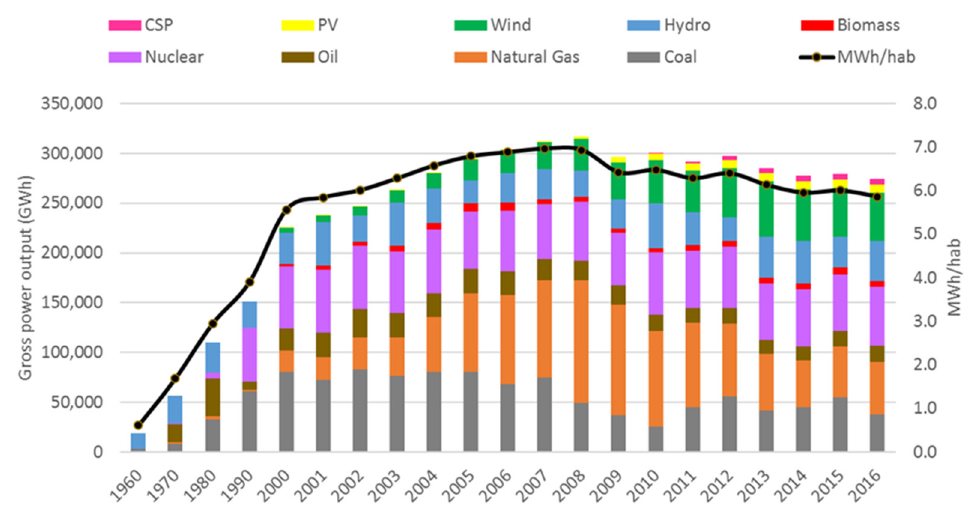
Figure 2. Historic data for electricity generation and technology mix in Spain (1960–2016).